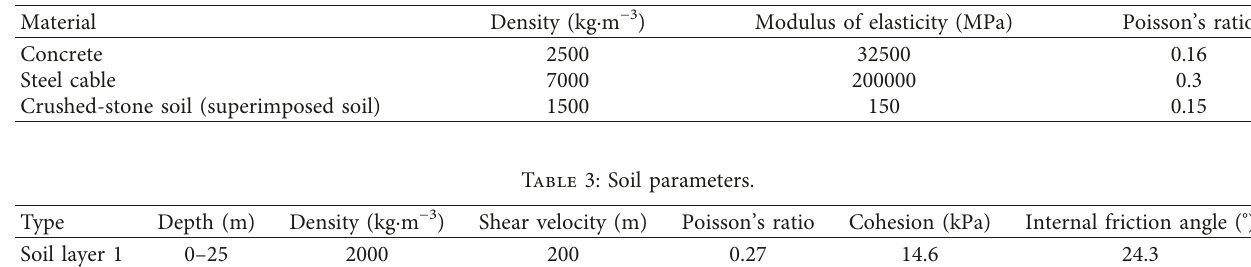
Table 2: Structural material parameters.